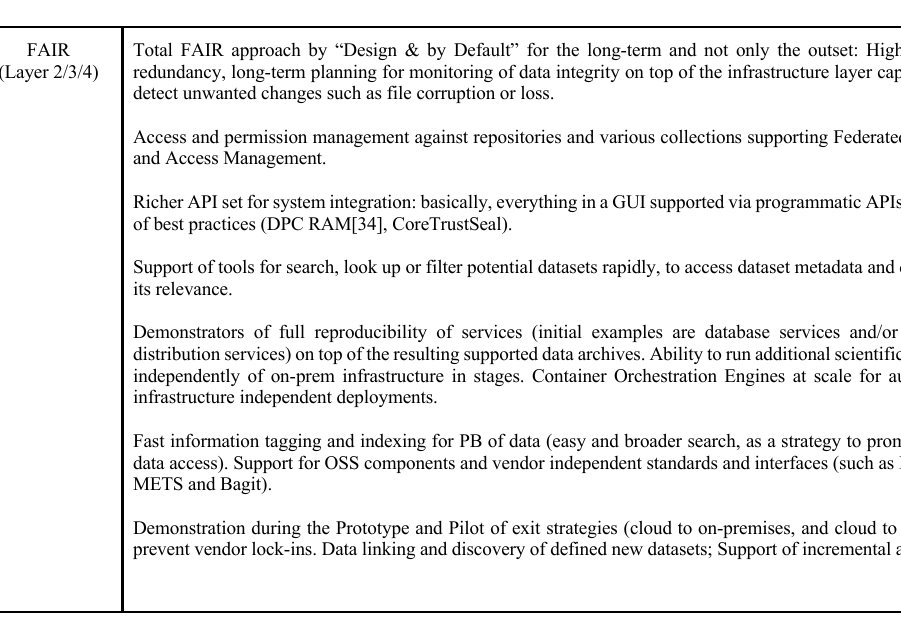
Fig. 8. Prototype architecture of the Arkivum consortium.